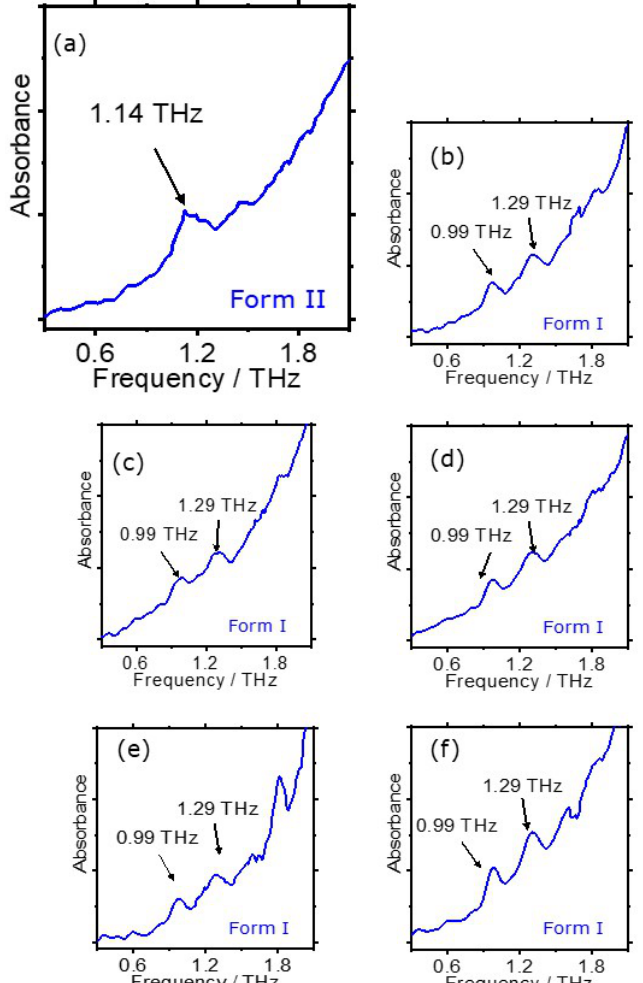
Figure 2. The terahertz spectra of different tablets containing ranitidine hydrochloride ( a ) Zantac from Glaxo, ( b ) Norton (Ranbaxy Laboratories), ( c ) Eastern Pharmaceuticals Ltd. (Middlesex, UK), ( d ) Apotex Inc. (Toronto, ON, Canada), ( e ) Tilmed, and ( f ) Generics UK Limited.